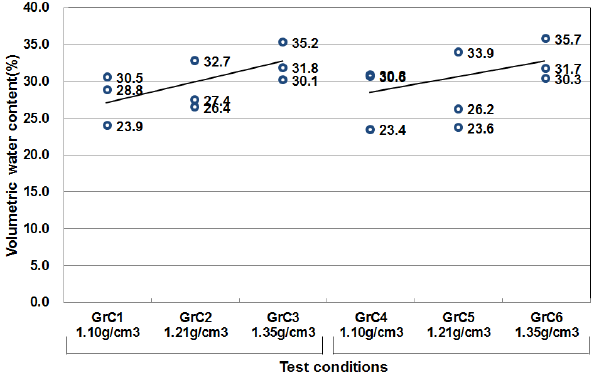
Figure 7. Residual volumetric water content of weathered granite soil.